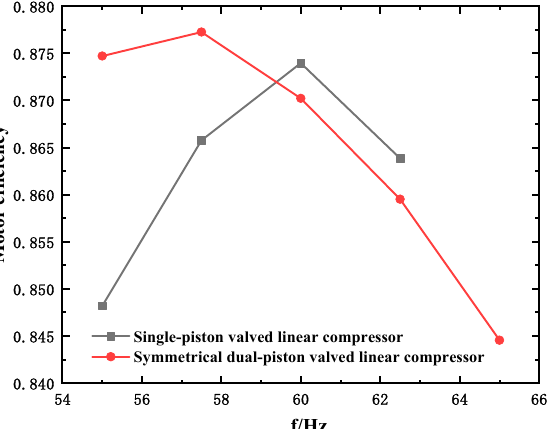
Figure 20. The motor efficiencies of the two types of linear compressors at different frequencies, obtained from the experiments.